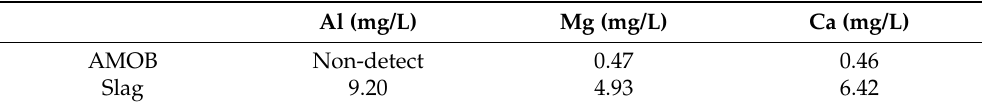
Table 3. Amount of Ca, Al, and Mg introduced into DI water from 0.02 g/mL adsorbent shaken at 150 rpm for 24